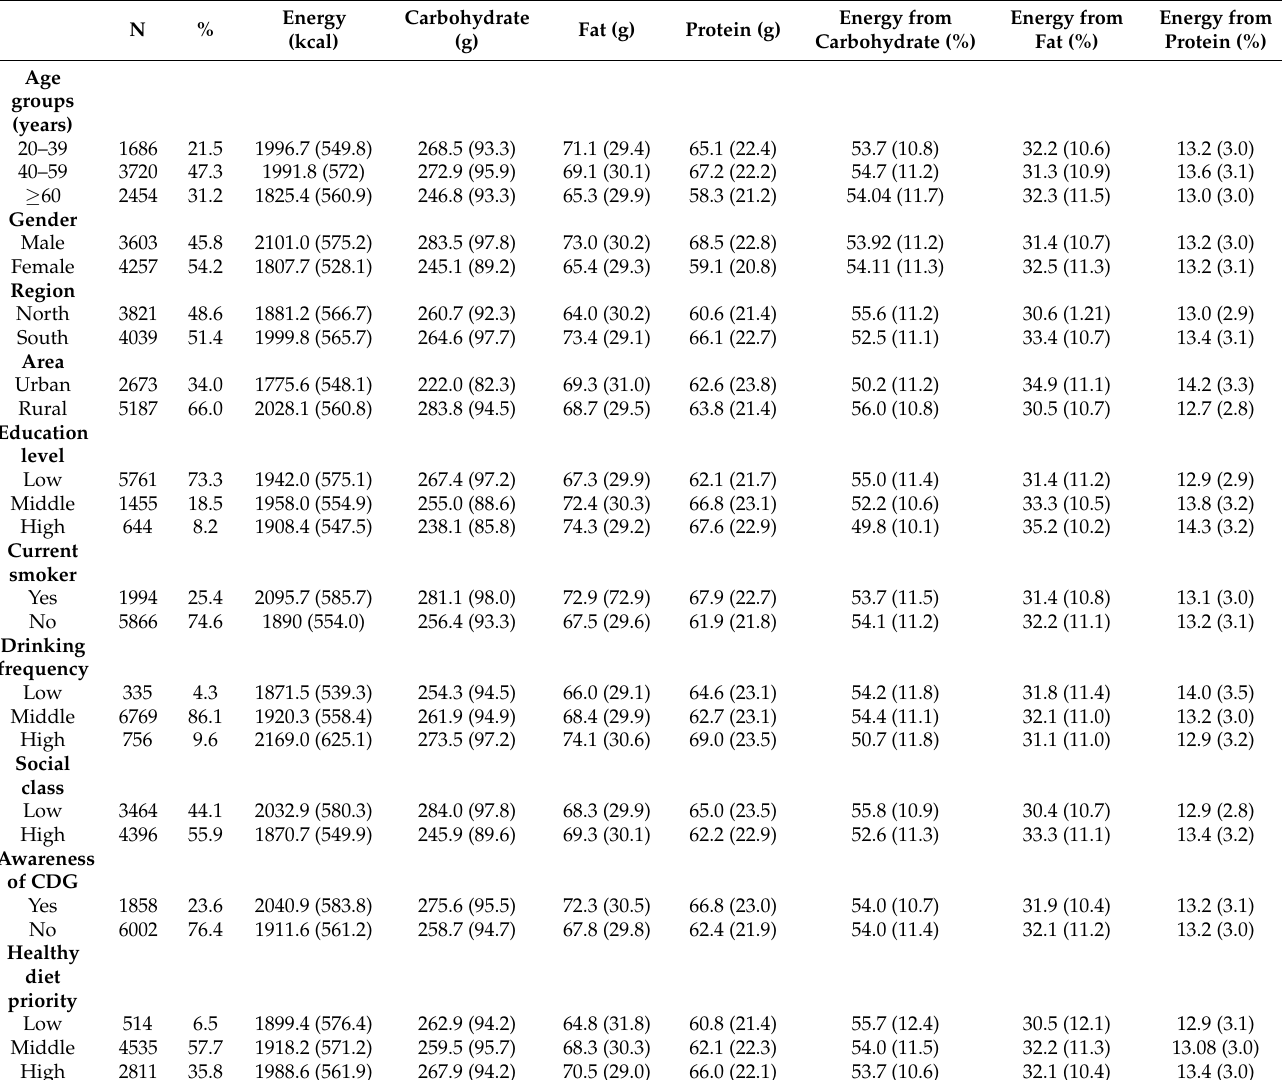
Table 1. Total energy intake, carbohydrate, fat, and protein intakes of